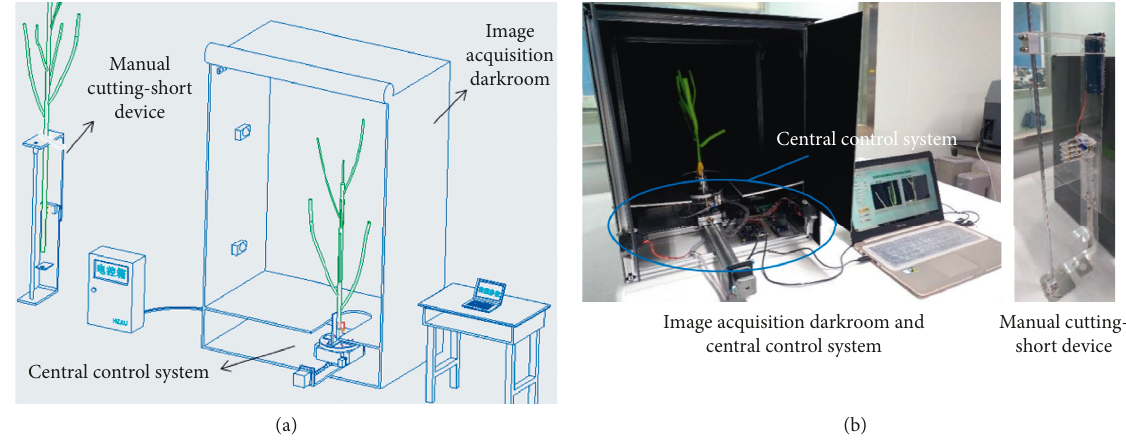
Figure 1: (a) Structure and (b) model of the image acquisition